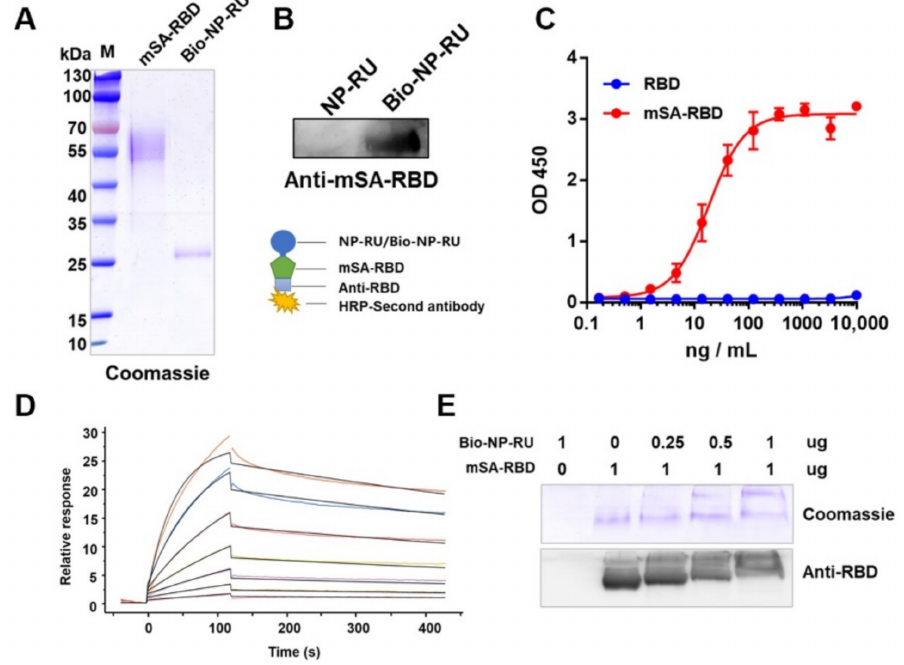
Figure 6. Protein antigen RBD was loaded on Bio-NP-RU through mSA-biotin. ( A ) Coomassie blue staining analysis of purified mSA-RBD and Bio-NP-RU. ( B ) NP-RU and Bio-NP-RU were separated through SDS-PAGE and transferred onto PVDF membranes. The connection between Bio-NP-RU and mSA-RBD was detected through Western blotting, in which mSA-RBD, Anti-RBD, and secondary antibodies were incubated in turn. ( C ) Functional ELISA was performed to measure the binding ability between Bio-NP-RU and mSA-RBD. We coated 96-well plates with Bio-NP-RU at 1 µ g/mL (100 µ L/well), and RBD and mSA-RBD were gradually diluted from 10 µ g/mL. ( D ) The Bio-NP-RU affinity of mSA-RBD was detected by SPR. mSA-RBD was immobilized on chip and Bio-NP-RU was analyzed. Lines with different colors indicated the different concentrations of Bio-NP-RU. ( E ) mSA-RBD was mixed at different proportions with Bio-NP-RUs and incubated at 37 ◦ C for 1 h. The combination between Bio-NP-RU and mSA-RBD was analyzed via Coomassie blue staining and Western blotting after being separated by non-denaturing electrophoresis. Each experiment was carried out at least